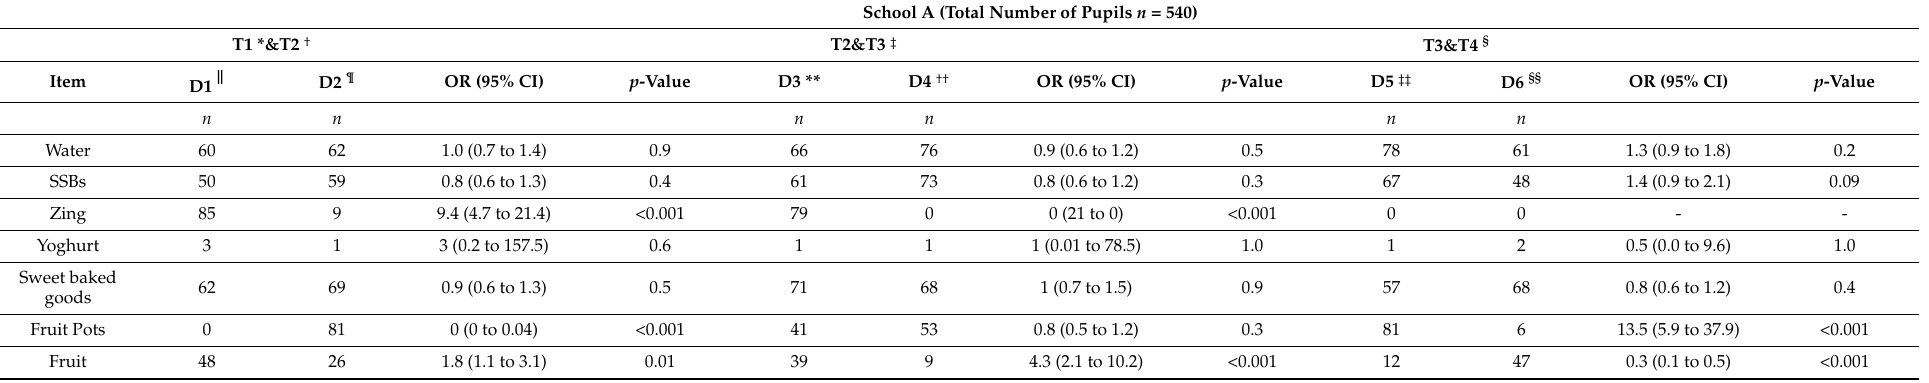
Table 3. School A: Effect of intervention on pupil’s food and drink purchases across time periods with OR, 95% CI and p -value.